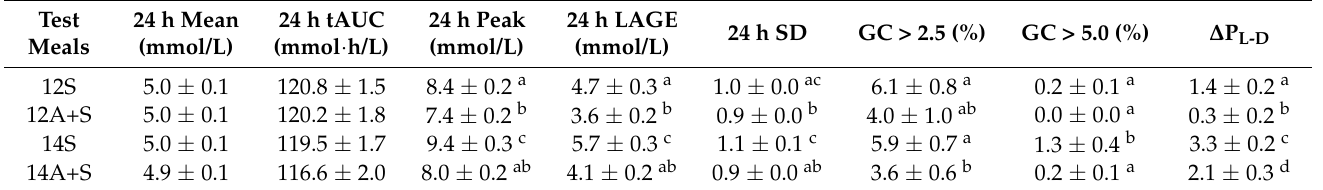
Table 4. The 24 h interstitial glucose parameters for four lunch trail conditions (mean ± SE, n =